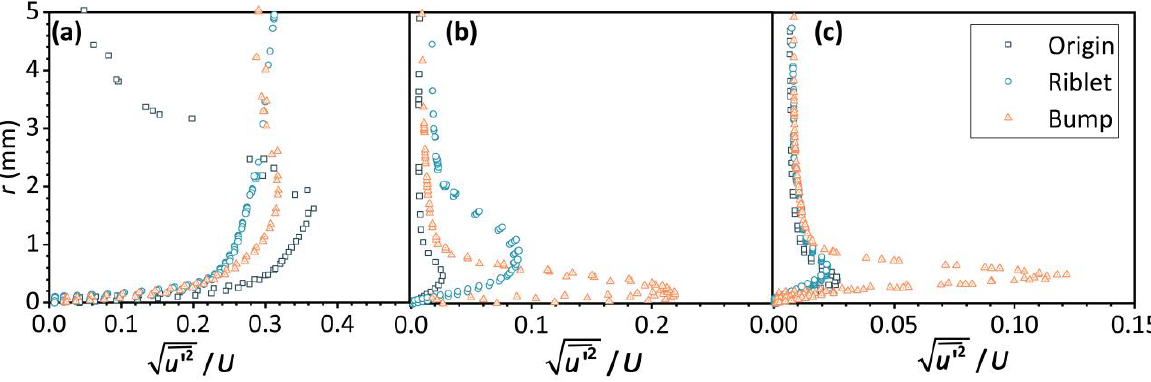
(cid:113) u (cid:48) 2 / U at different position: